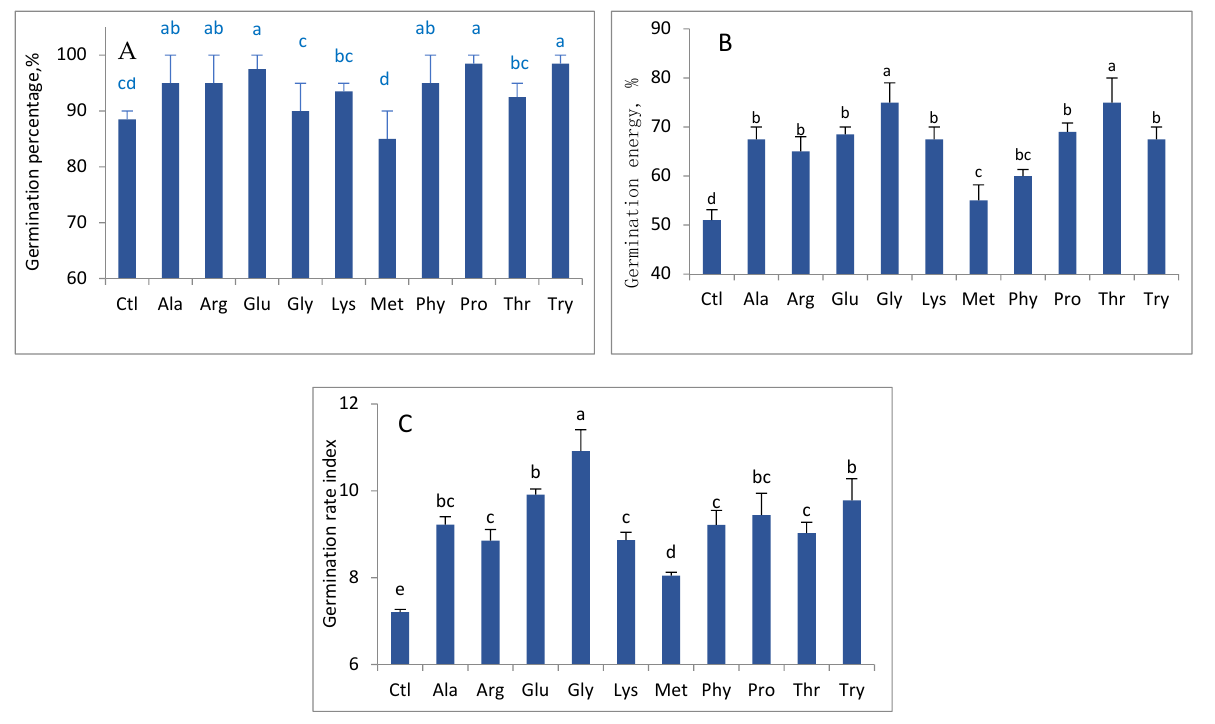
Figure 1. Effect of priming onion seeds with exogenous amino acids. ( A ) — Germination percentage, %; ( B ) — Germination index, %; ( C ) — Germination rate index, %. Ctl (Control); Ala (Alanine); Arg (Arginine); Glu (Glutamine); Gly (Glycine); Lys (Lysine); Met (Methionine); Phy (Phenylalanine); Pro (Proline); Thr (threonine); Try (tryptophan). Columns that share the same letter(s) are not statistically significant at p ≤ 0.01. According to the shown data of root length after seven days of priming (RL-7), pre- priming onion seeds with Glu and Try treatments produced a root length of more than 2.8 cm (Figure 2C). The longest radicle (3.0 cm) was obtained from seeds primed with Glutamine and increased by over 55% compared with non-primed (1.1 cm). At 14 days after priming, all AA increased the length of the root system compared with the control, except with the arginine (Arg) treatment (Figure 3B).